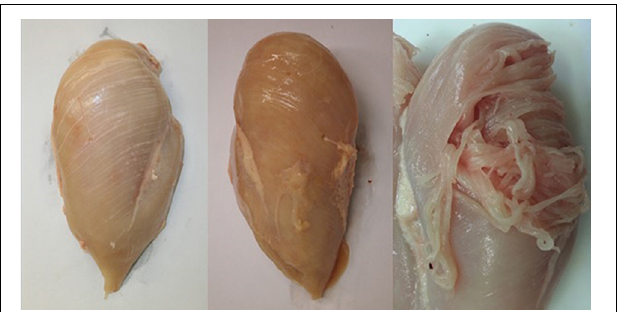
FIGURE 1 | Breast fillets showing the novel myopathies white striping (WS; left), wooden breast (WB; middle), and spaghetti breast (SB;